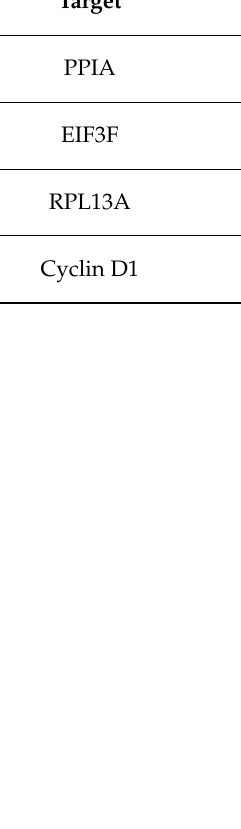
Table 2. Primers used to quantify TCR β germline